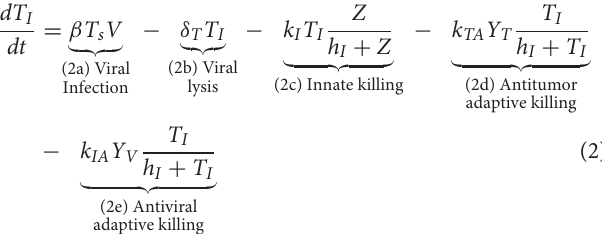
Equation (3) models the virus population, with term (3a) representing the addition of new viral particles that are released when an infected tumor cell lyses. The parameter b T denotes the viral burst size released from each infected cell, which we assume to be 50 viral particles per cell, the estimated burst